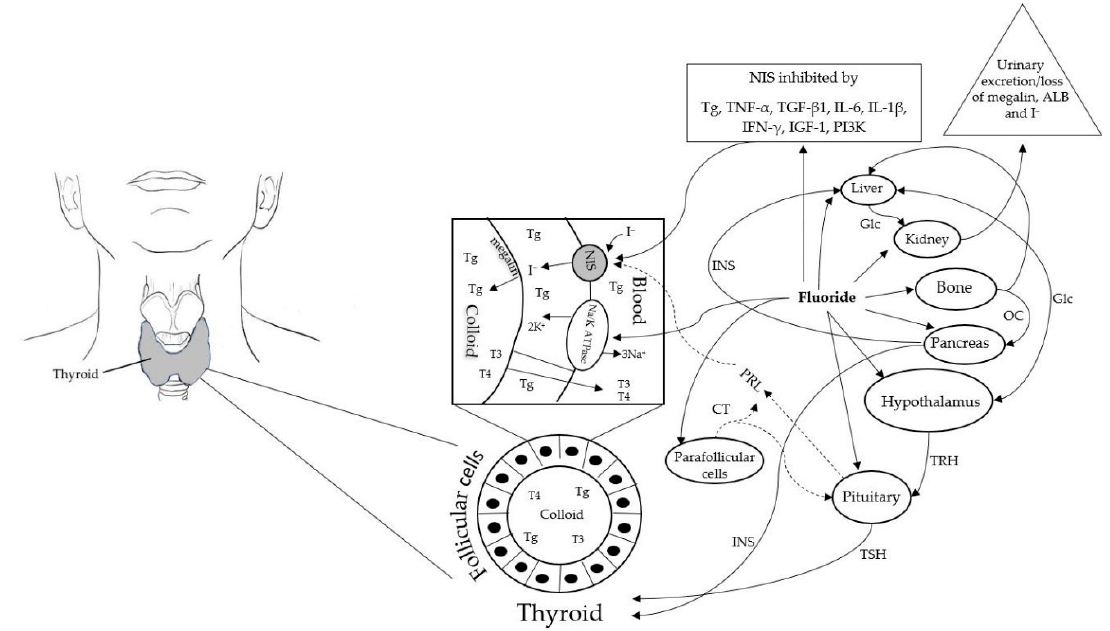
Figure 1. Schematic representation of the role of NIS and Na+, K+-ATPase in normal thyroid follicular cells showing the key aspects of iodine transport, thyroid hormone synthesis and molecular mechanisms of inhibition of NIS by fluoride. Abbreviations: NIS: Sodium/Iodide Symporter; ALD: Albumin;